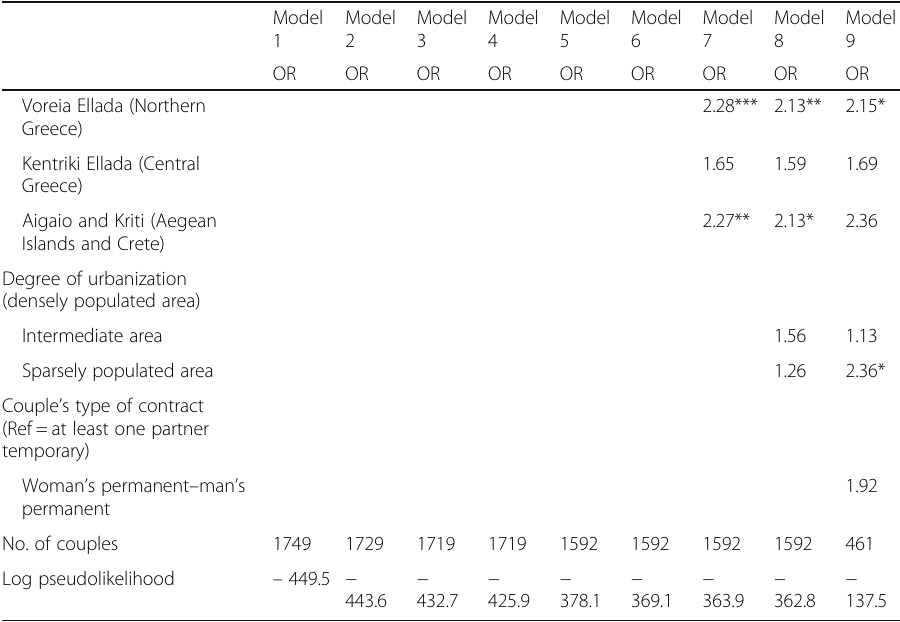
Table 4 Transition to first child in Greece, nested random effects models (without interactions)